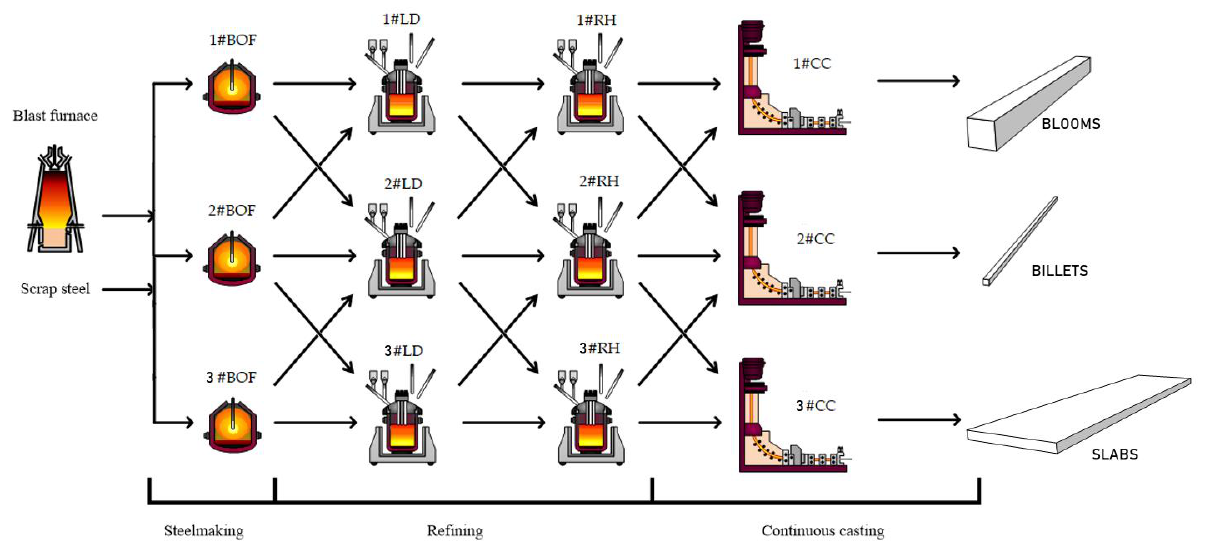
Figure 1. Phases of a typical Steelmaking Continuous Casting